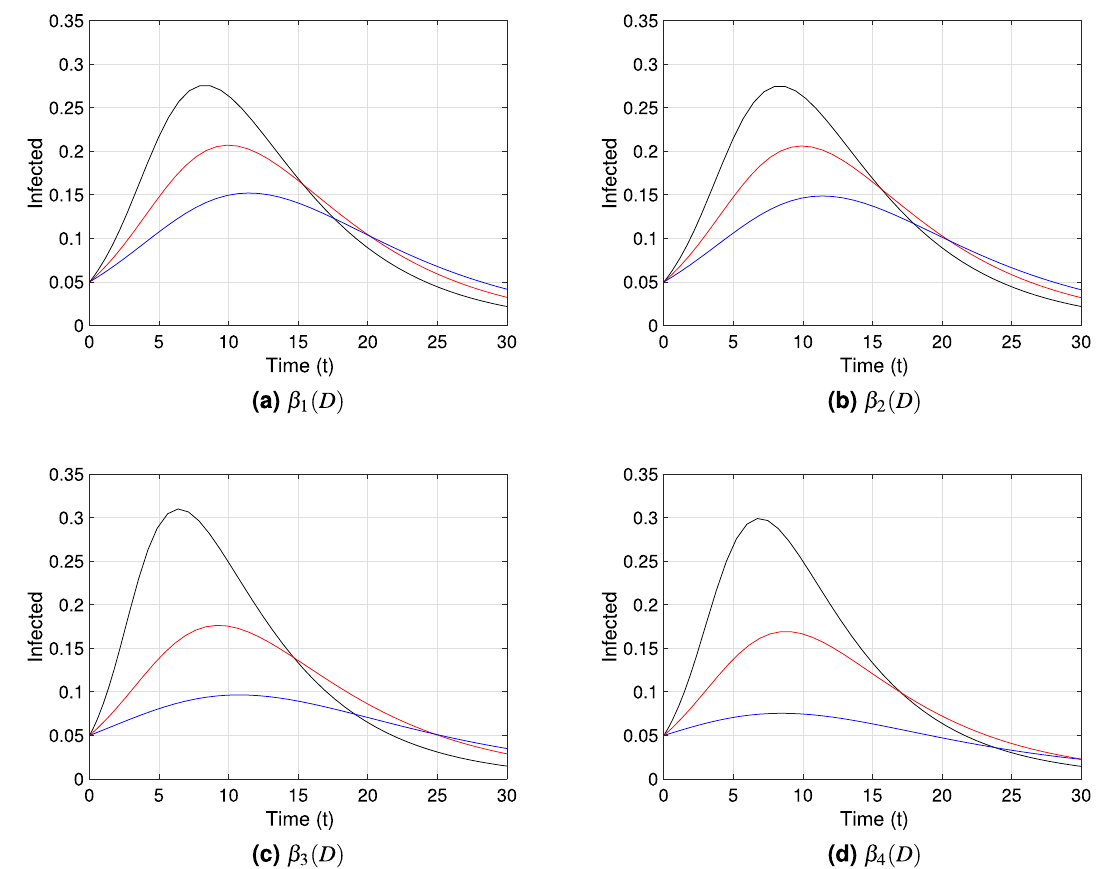
Figure 5. Point prevalence, I ( t )/ N , from the system in Eq. (1) with respect to time for different transmission functional forms and ν = 1.5 . Black, red and blue curves correspond to D ∗ = 0.75 ( m ) , D ∗ = 1.05 ( m ) , and D ∗ = 1.35 ( m ) respectively. These correspond to societies of small ([0, 100)), medium ([100, 120]) and large ( [ 120, ∞ ) ) natural-distance types respectively (see Table 1). The other parameter values were taken to be β ∗ = 0.5 ; γ = 0.2 , ν = 1.5 , (cid:31) 1 = 0.03 , (cid:31) 2 = 0.3 . The R 0 value for each society are for ( a ) and ( b ): R 0 = 3.1 (black), R 0 = 2.5 (red), R 0 = 2.0 (blue); ( c ): R 0 = 4.1 (black), R 0 = 2.5 (red), R 0 = 1.7 (blue); ( d ): R 0 = 3.7 (black), R 0 = 2.5 (red), R 0 = 1.5 (blue). The initial condition D ( 0 ) = D ∗ was used for each type of